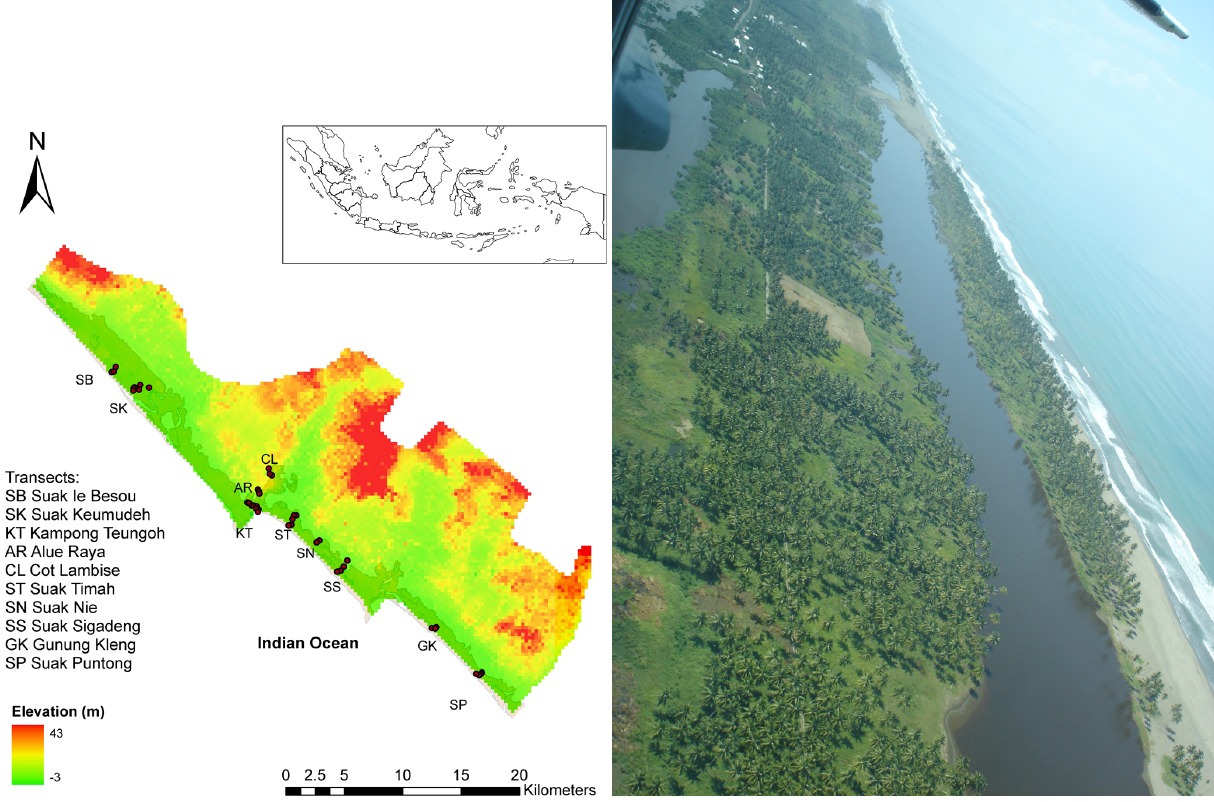
Fig. 2. (left) Digital elevation model extracted from Siemon et al. (2007) for the study area around Meulaboh during the tsunami event in Aceh, the westernmost province on the Indonesia map. Dots indicate the points sampled during this study; (right) ridges and swales parallel to the coast line about 15km SE of